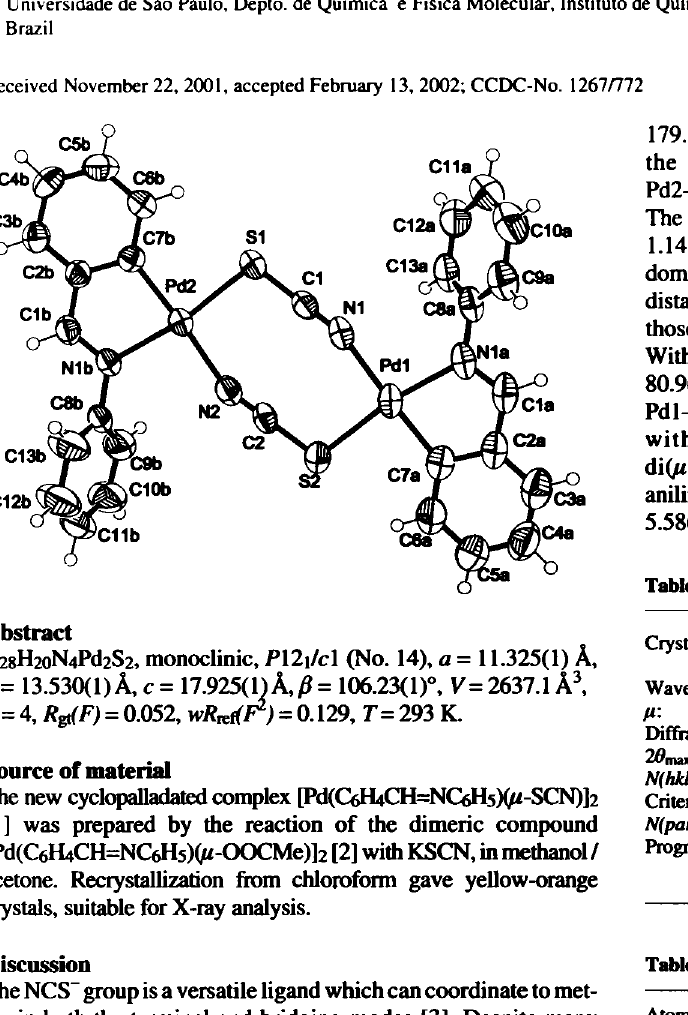
Table 2. Atomic coordinates and displacement parameters (in Â 2